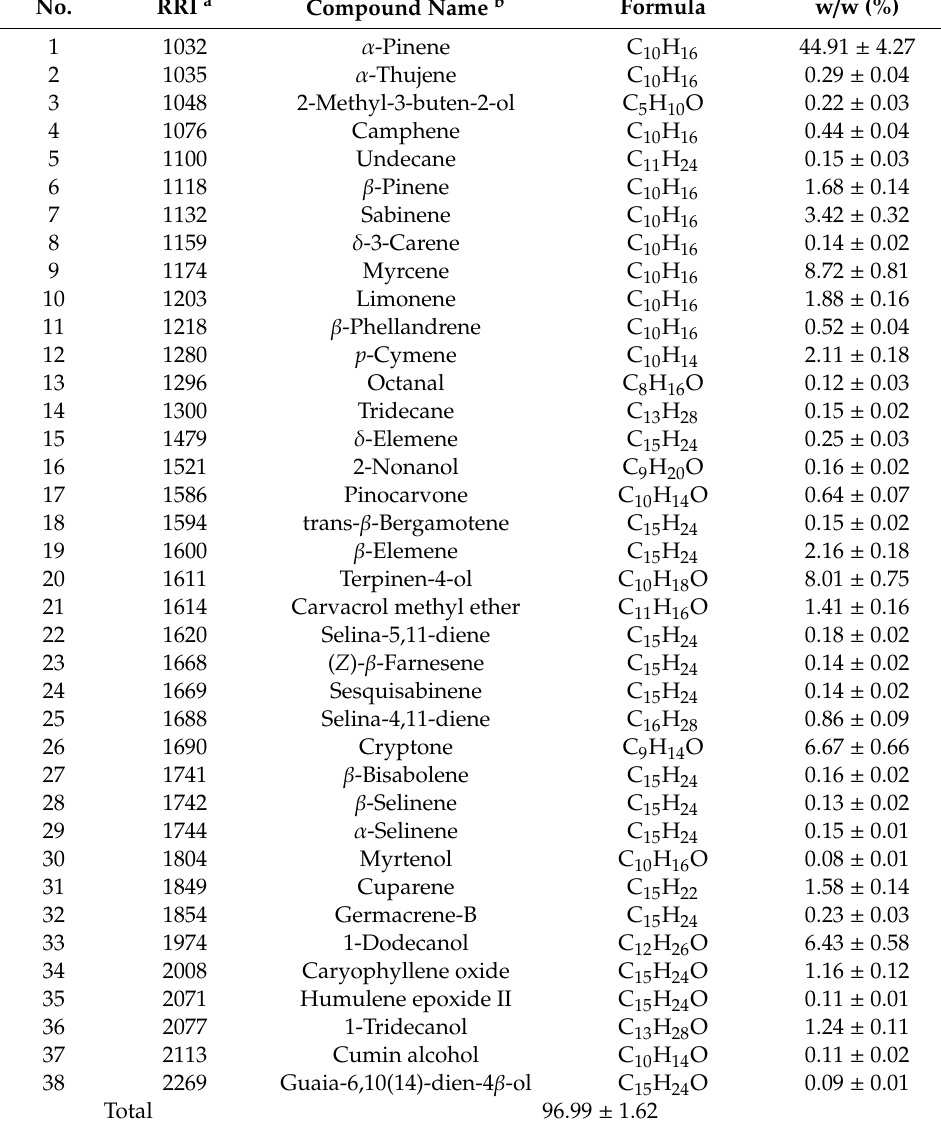
Table 1. Chemical composition (w / w, mean value ± SD) of Angelica dahurica cv. Yubaizhi essential oil